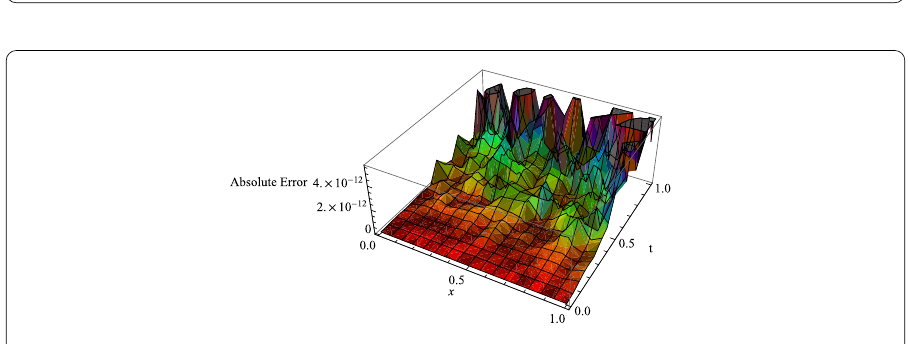
Figure 6 Plot of absolute error E 7 ( w ) = | w ( x , t ) – w 7 ( x , t ) | using HATM when λ =